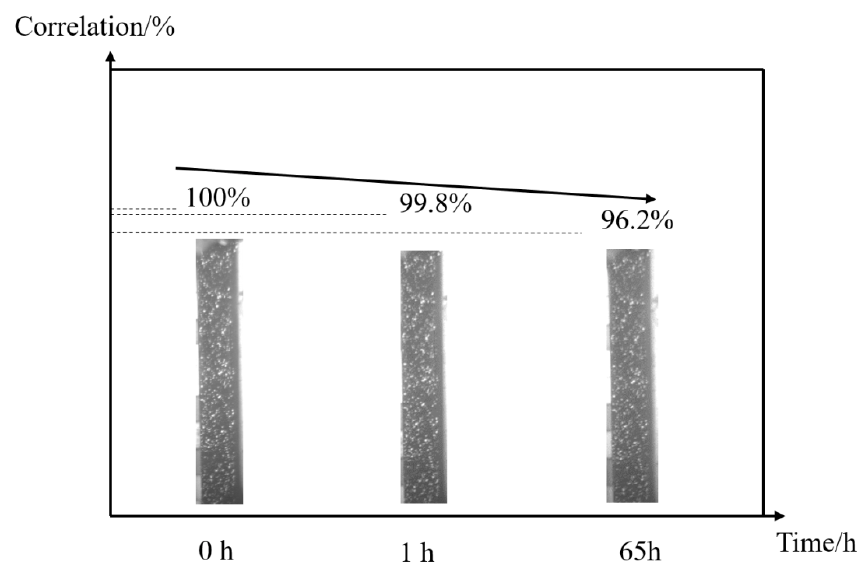
Figure 7. Speckle evolution assessed by correlation calculation during the creep